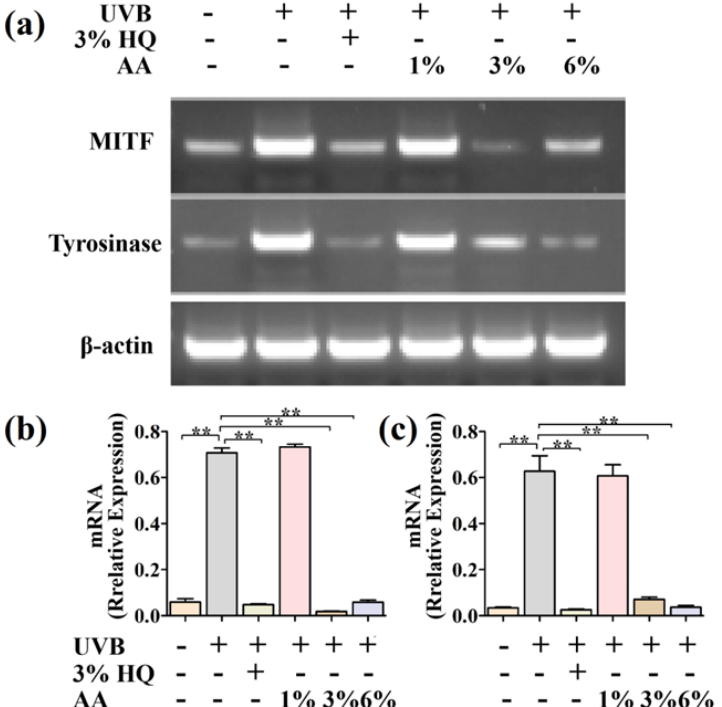
Figure 7. Effects of AA on the expression of mRNA of MITF and tyrosinase of dorsal skin ( a ). The mRNA levels of MITF ( b ) and tyrosinase ( c ) proteins were quantified by densitometry. Data are expressed as mean ± SEM. ** p < 0.01. ( n = 6 per group).